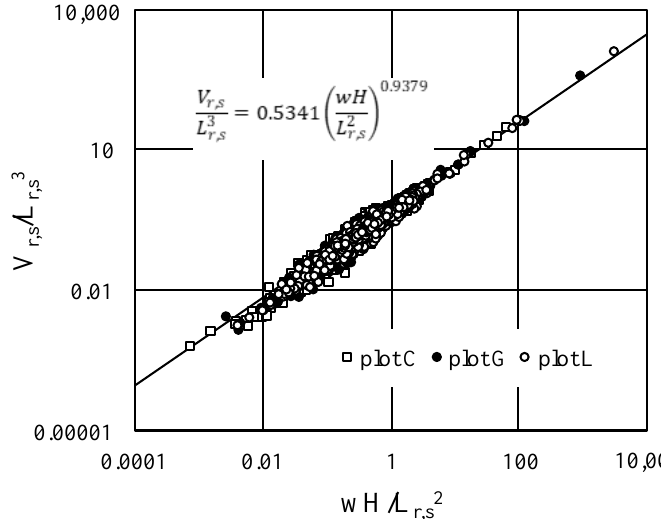
Figure 17. Comparison between the dimensionless power equation and the ( wH / L r,s 2 , V r,s / L r,s 3 ) pairs detected for the plots L (44 m × 8 m), G (33 m × 8 m), and C (22 m × 8 m) using the automatic extraction of the rills (modified from [62]).